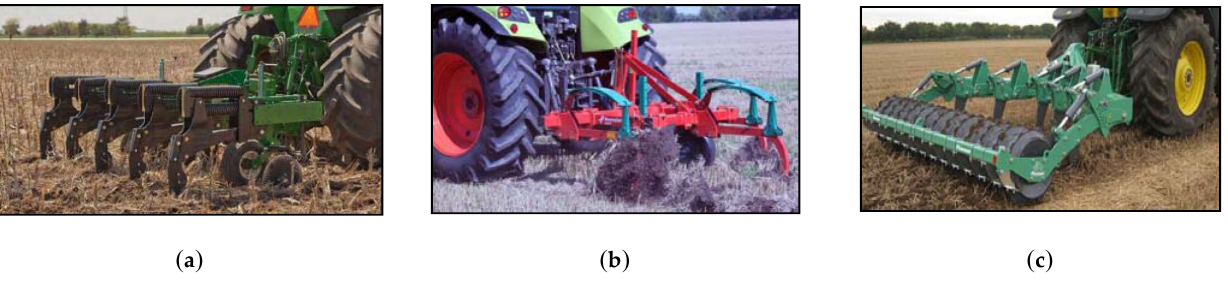
Figure 3. ( a ) Great Plains SS1300 subsoiler